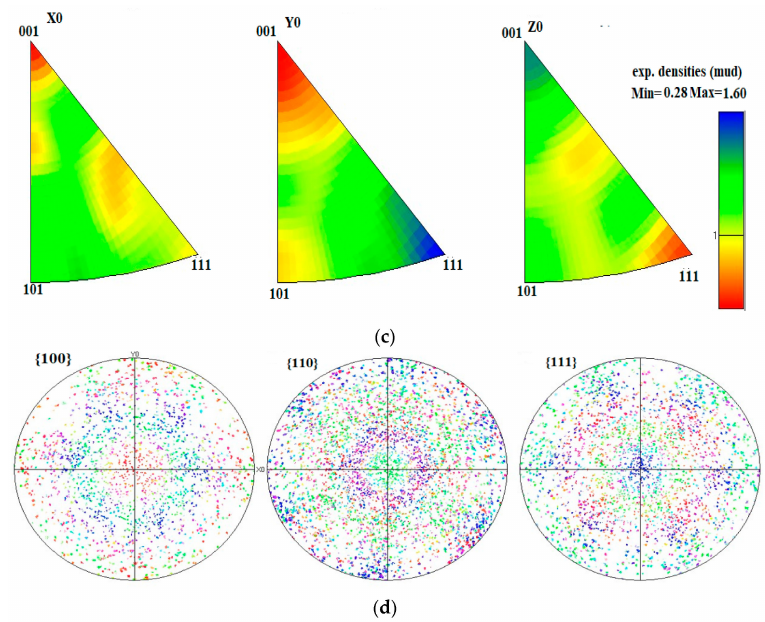
Figure 3. EBSD results for5Mg0.5Mn0.5Cu alloy after annealing: ( a ) subgrain structure; ( b ) fraction mapping; ( c ) inverse pole figure; ( d ) pole